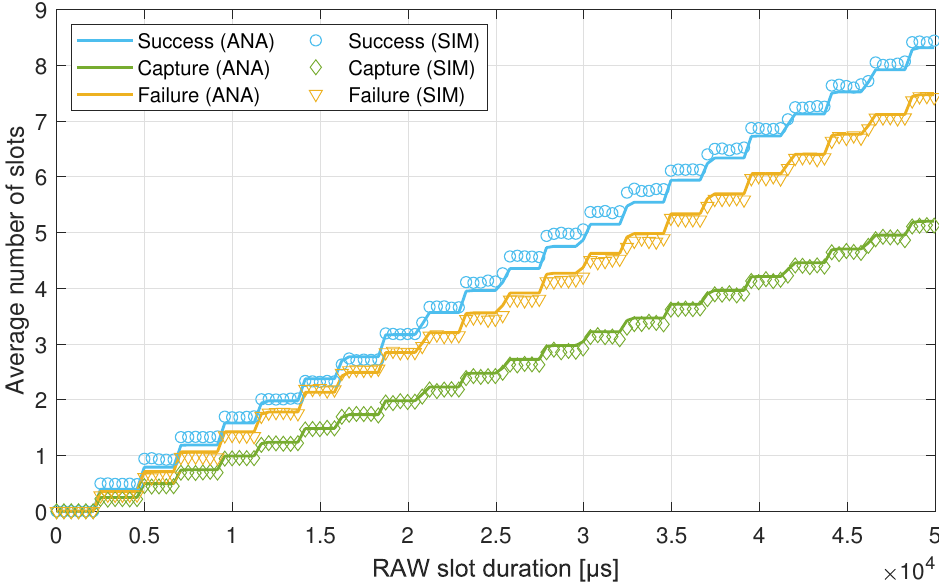
Figure 7. Average number of slots with successful single transmission, captured packet, and failure, within the RAW slot interval, with channel capture threshold z =